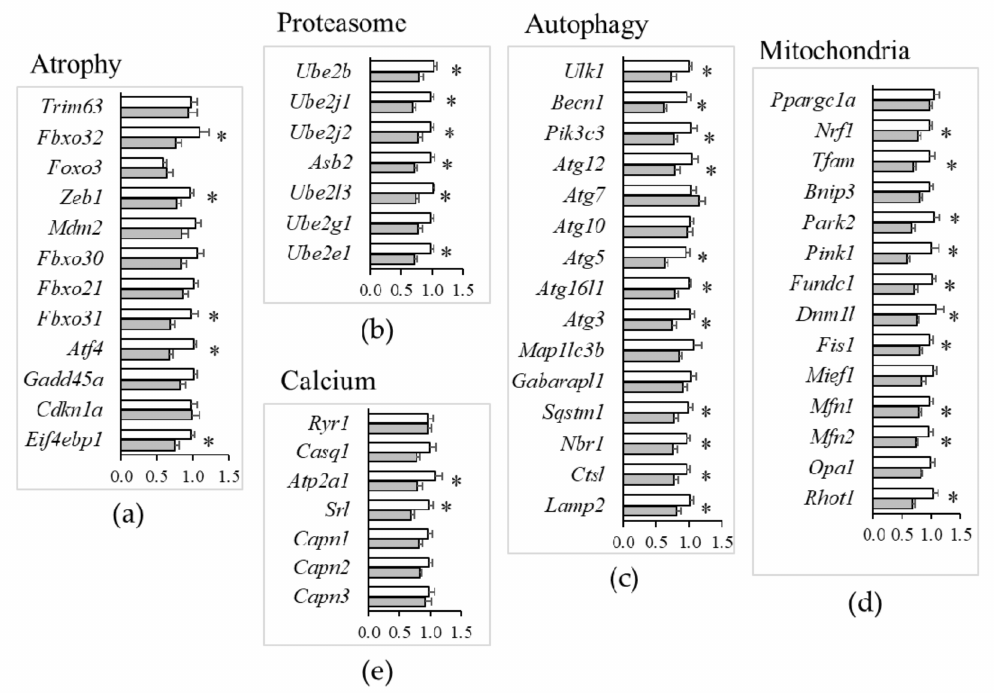
Figure 7. Muscle gene expression in mice fed a mildly Mg 2+ -deficient diet. TaqMan low-density array (TLDA) was used to measure mRNA levels of genes critical for muscle physiology of mice fed either a control (white bars) or a mildly (grey bars) Mg 2+ -deficient diet. Genes involved in muscle atrophy ( a ), proteostasis ( b ), autophagy ( c ), mitochondrial dynamics ( d ) and calcium homeostasis ( e ) were analyzed. Results are means ± SE (N = 12). * indicates significant difference ( P < 0.05) from the CTR